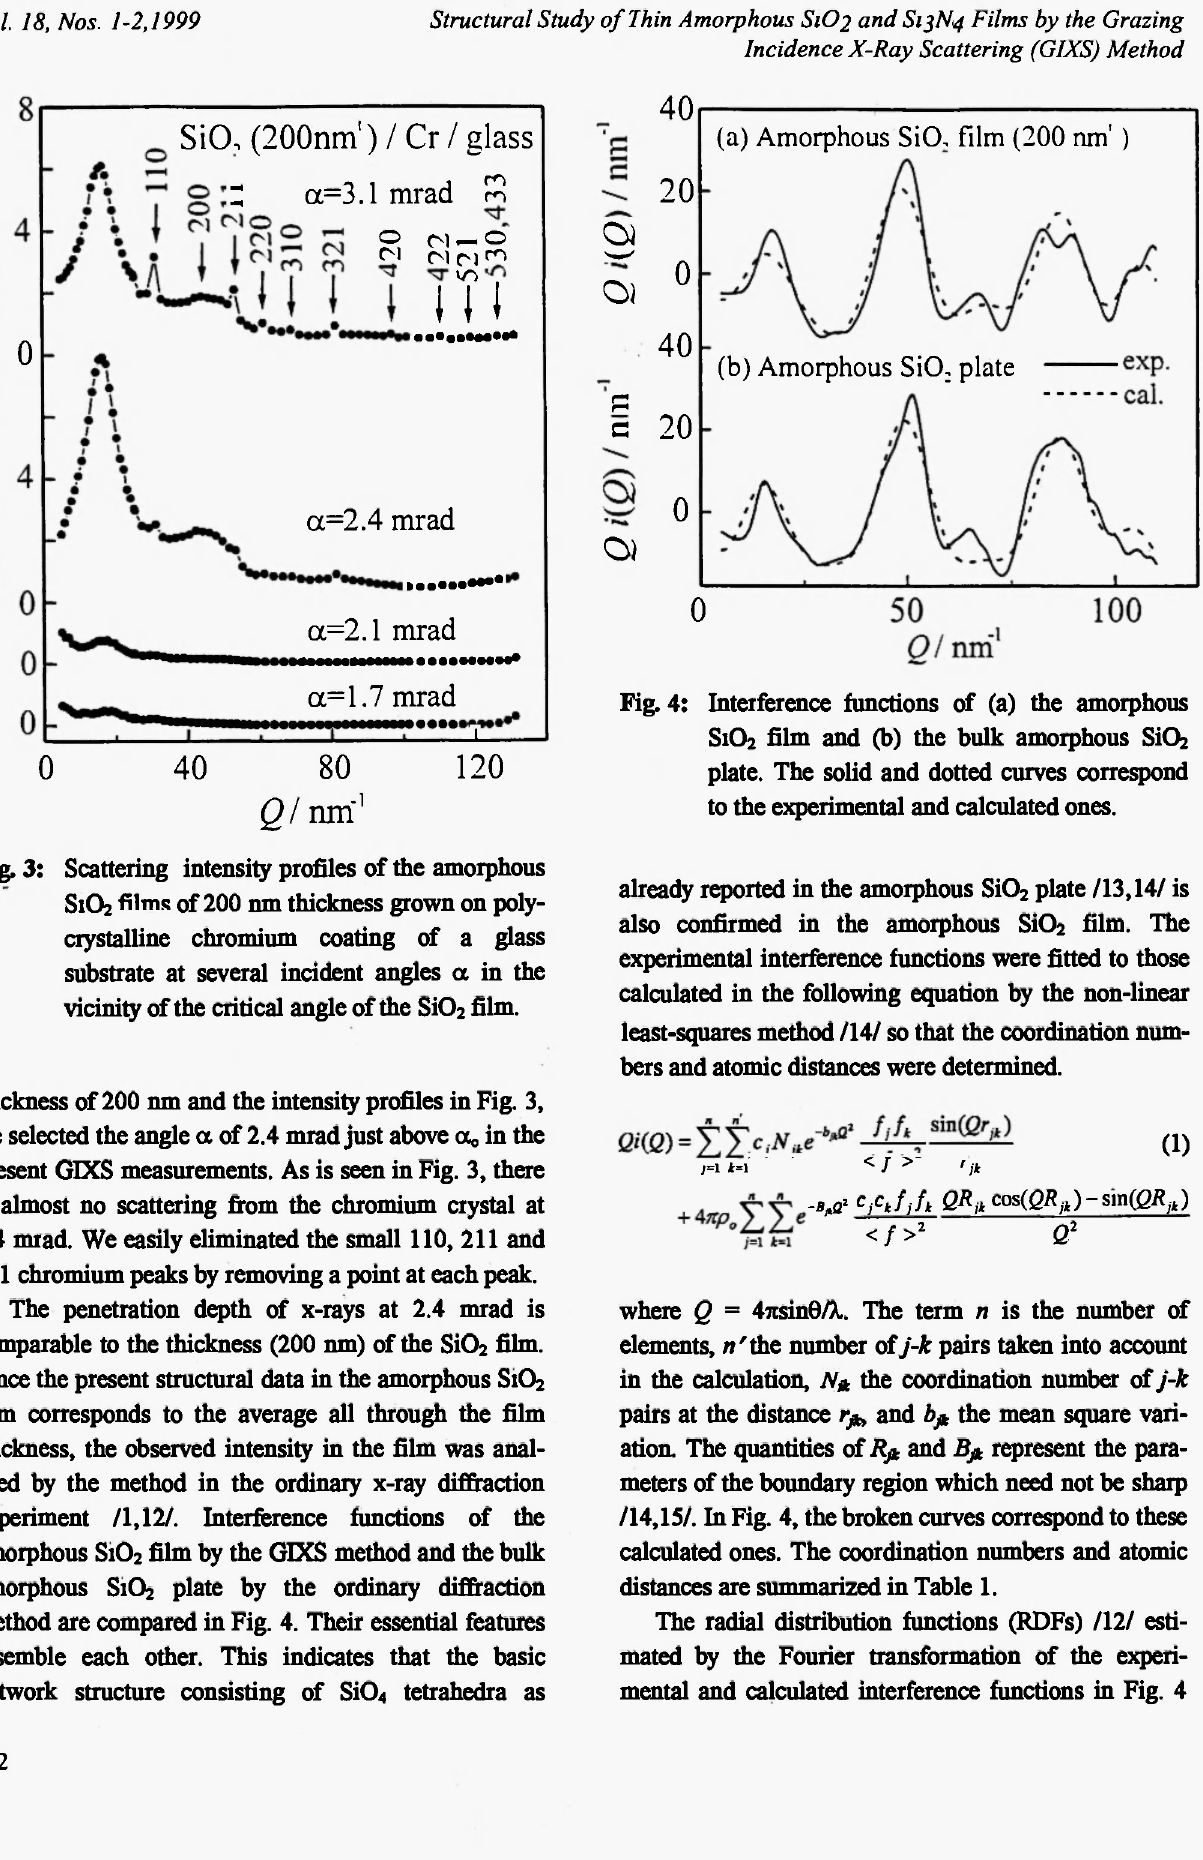
Fig. 3: Scattering intensity profiles of the amorphous S1O2 films of 200 nm thickness grown on poly- crystalline chromium coating of a glass substrate at several incident angles α in the vicinity of the critical angle of the Si0